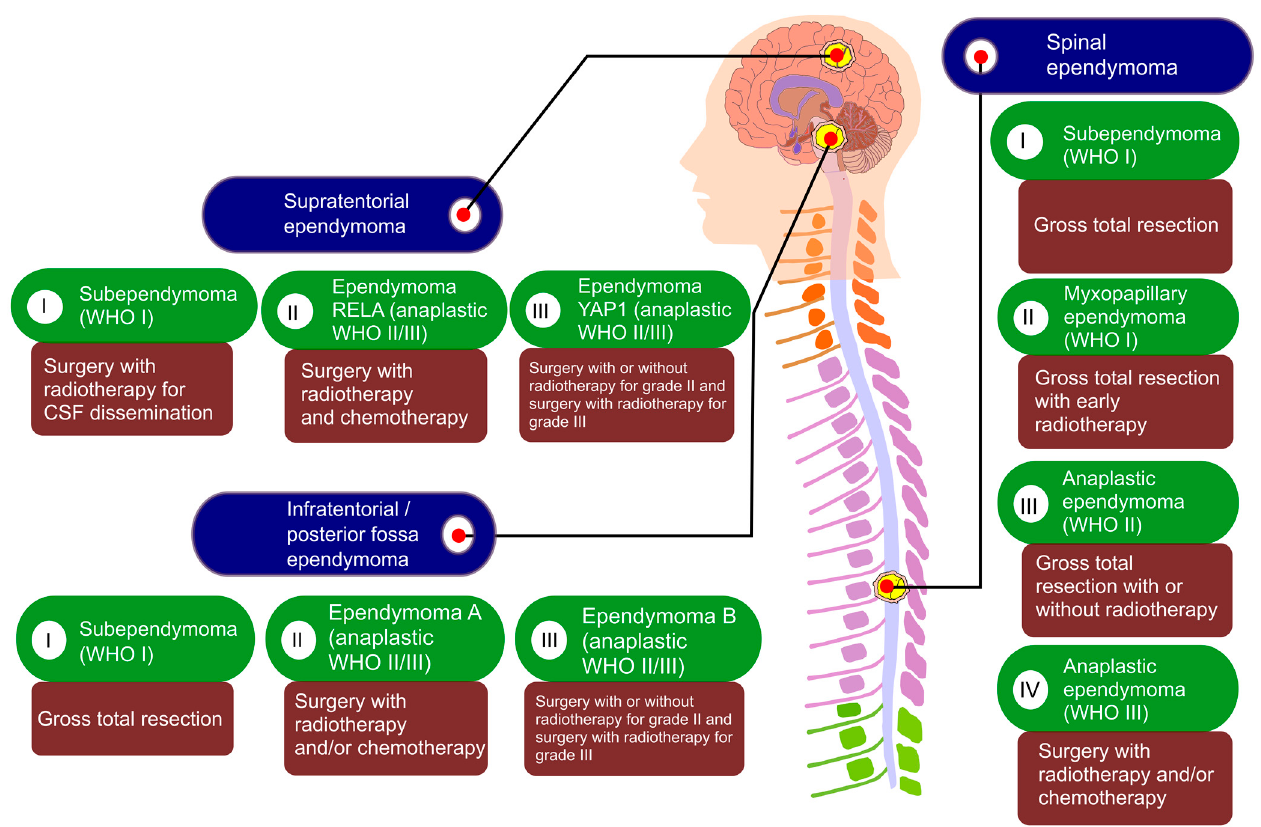
Figure 4. Possible therapeutic approaches. This figure represents the different types of ependymomas depending on their positions and WHO’s classifications, and their therapeutic advances. Surgical resection is considered a primary therapeutic approach, while, in many cases, RT with surgery shows a greater response. Chemotherapy can be also used for anaplastic ependymomas as a therapeutic method. For subependymomas, only surgery can be curative, RT is essential for recurrent subependymomas. Although in some cases, it is important to deliver RT on the tumor region after surgery for myxopapillary ependymomas, most of the cases show great results only with surgery. In WHO II ependymomas, targeted treatment is to acquire GTR, RT is required after STR. For anaplastic ependymomas, the suggested therapy is surgery with RT. However, in some exceptional cases such as recurrent anaplastic ependymoma or very young children, chemotherapy is required after surgery with or without RT because RT has toxic effects on children’s developing brains and sometimes surgery with RT fails to show effective results in recurrent disease. However, a lack of an established targeted chemotherapy makes surgery and RT primary treatment options [16,139] .